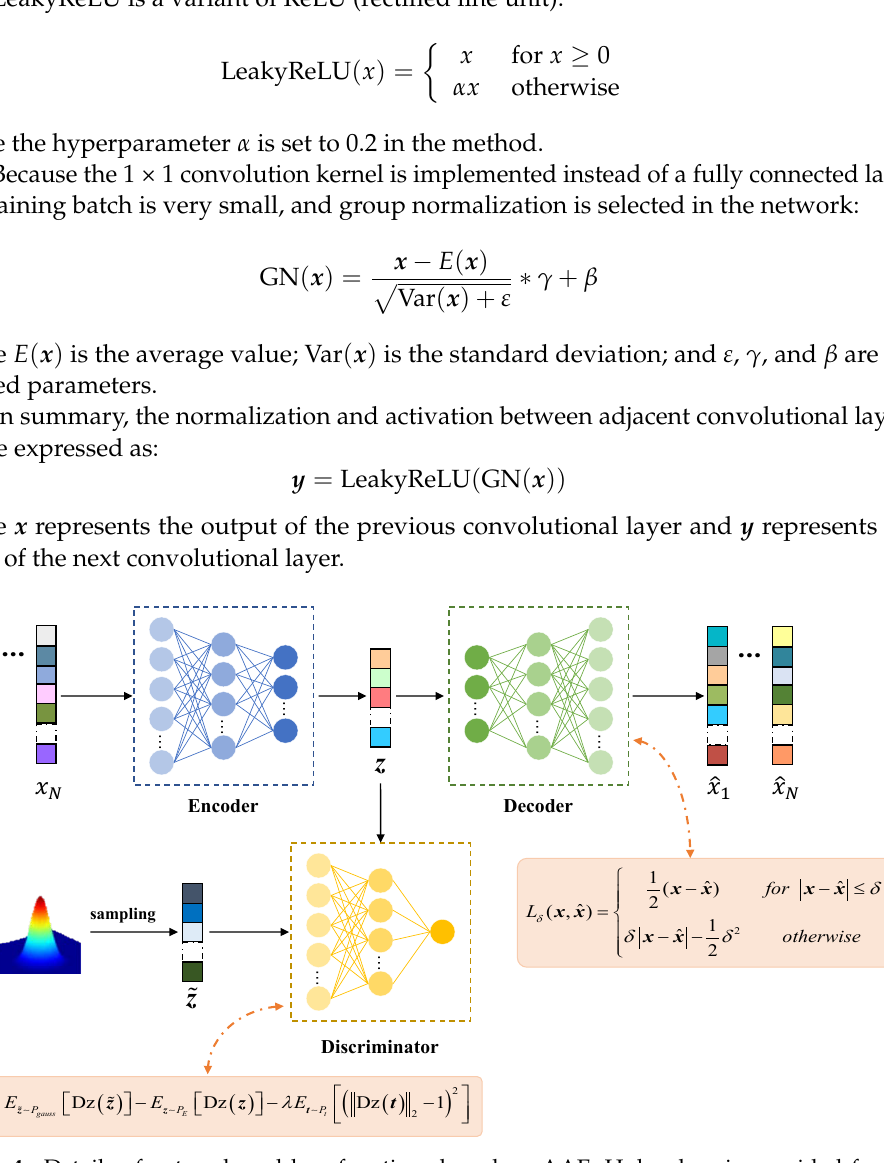
Figure 4. Details of network and loss functions based on AAE. Huber loss is provided for the encoder–decoder, and Wgan-gp loss is provided for the